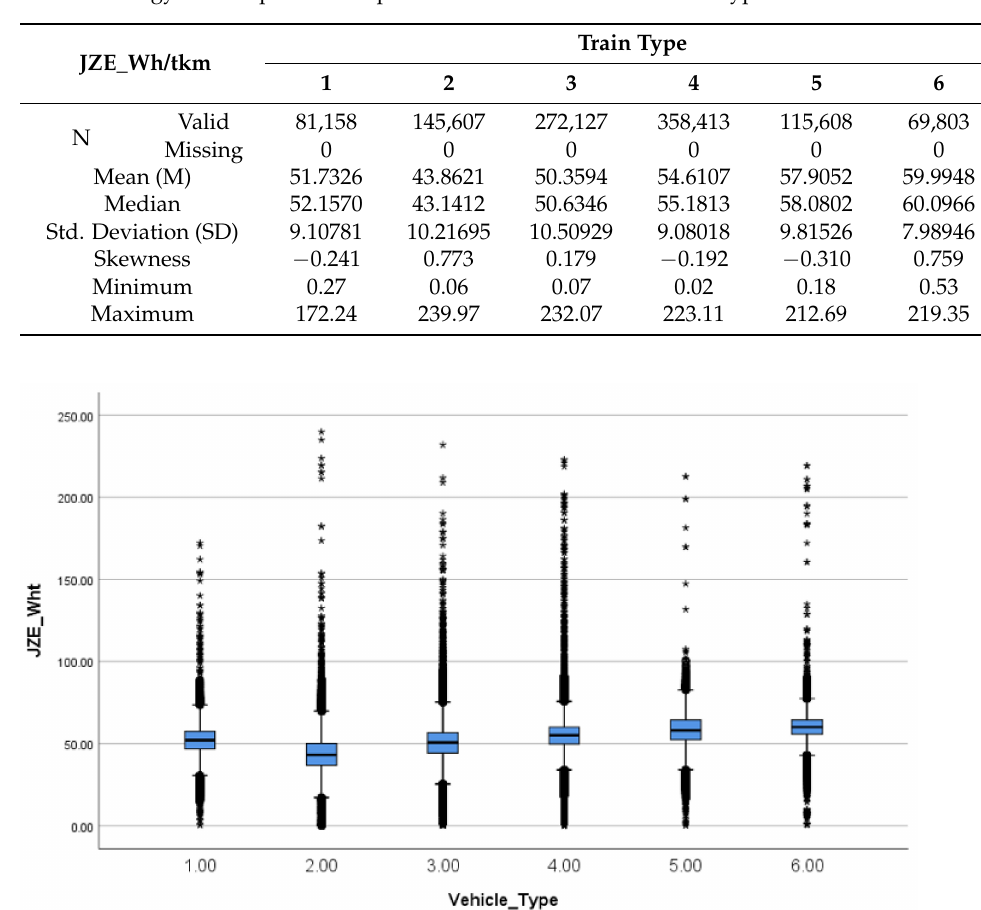
Figure 2. The comparison of energy consumption for each of the vehicle types. Stars denote atypical